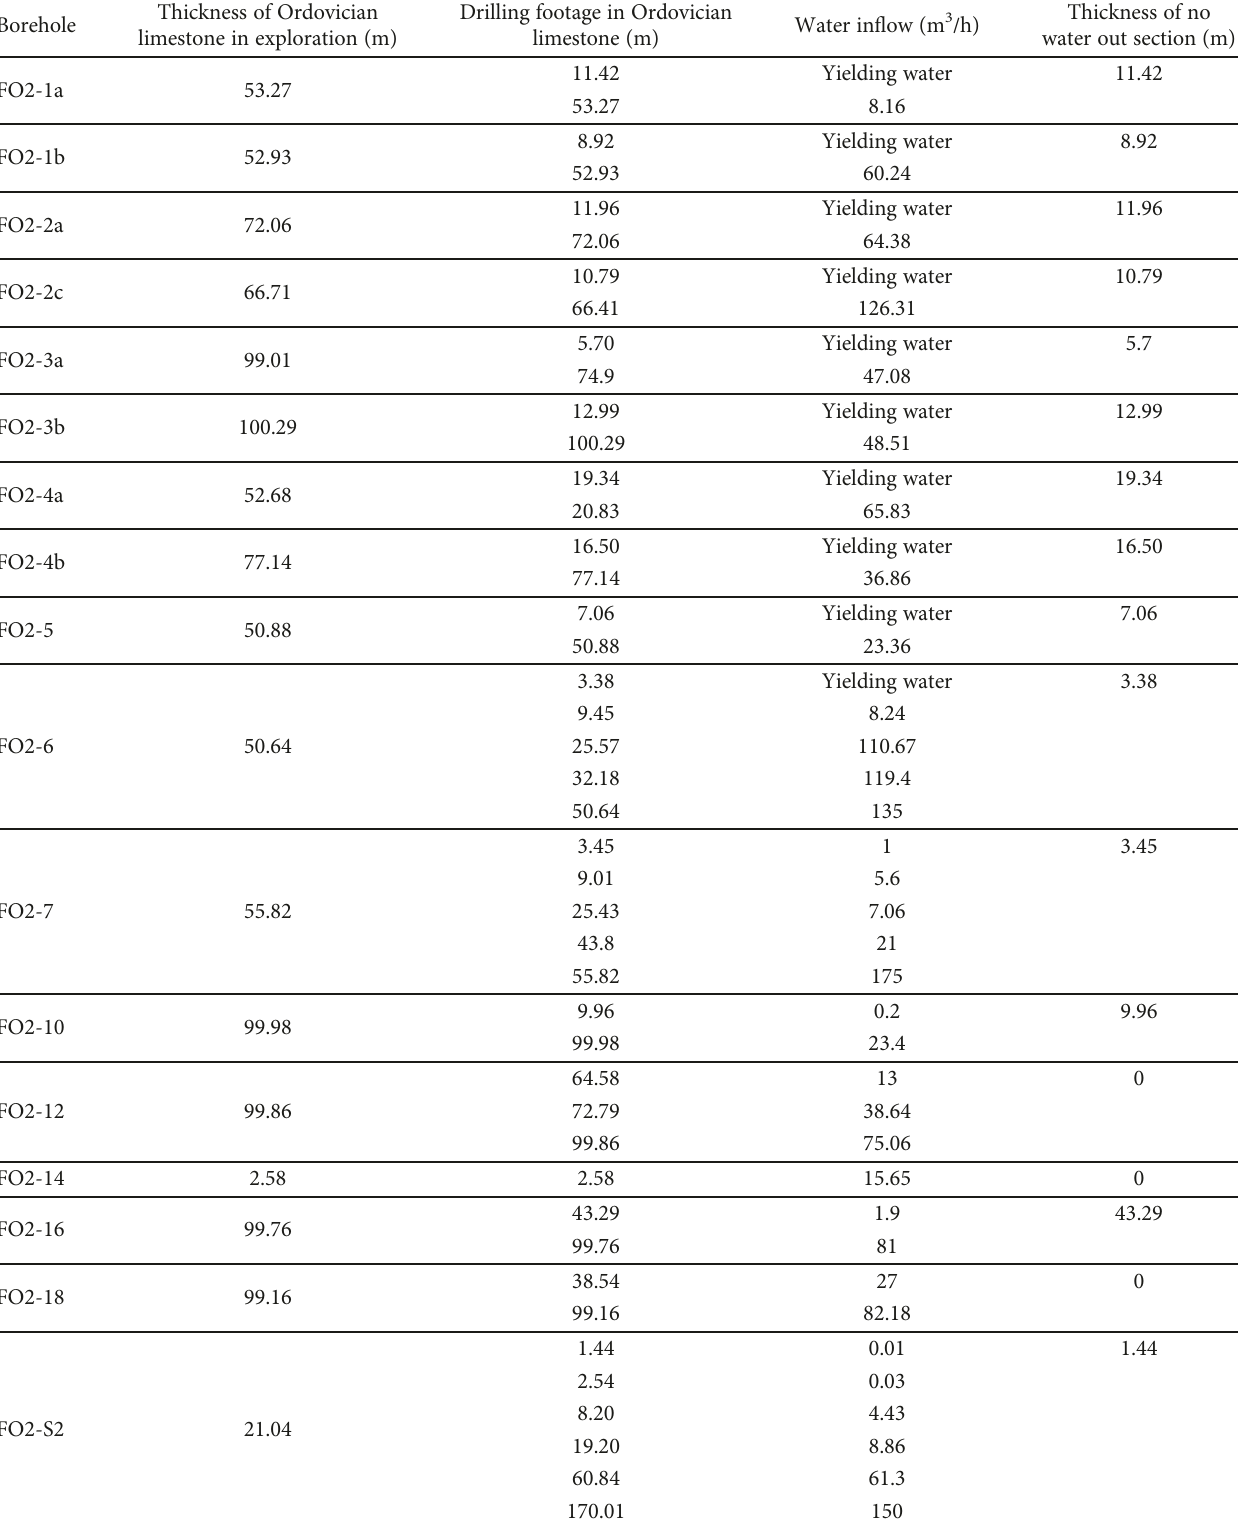
Table 1: The water exit conditions of underground drain